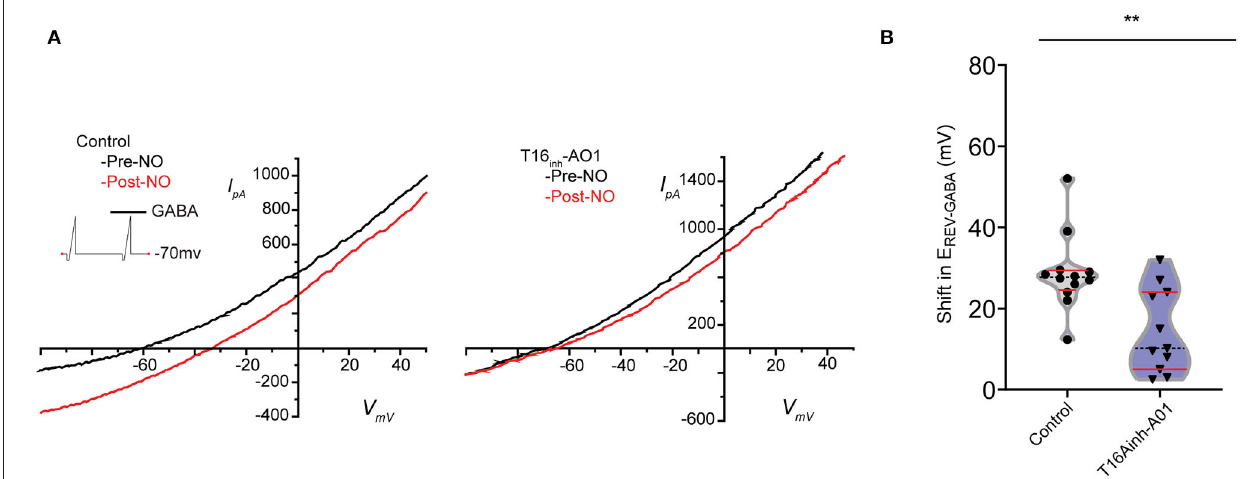
FIGURE 2 | Pharmacological inhibition of TMEM16A reduces the transient shift in E revGABA . (A) Current–voltage relationship for leak subtracted GABA-gated currents recorded before and after NO injection in control and TMEM16A inhibitor (T16 inh -AO1) conditions. (B) Truncated violin plots for the mean shift in the reversal potential of GABA-gated currents (E revGABA ). The shape of the violin shows frequency distribution of the data, top and bottom of the violin are data extrema, red lines are quartiles, and the dashed line is the median of the data. The mean shift in E revGABA was reduced, and frequency distribution becomes bimodal when TMEM16A inhibitor ( n = 11) was in the external solution compared to control conditions ( n = 12). Recordings were from E16 cultures (Welch’s t -test, ** denotes p <